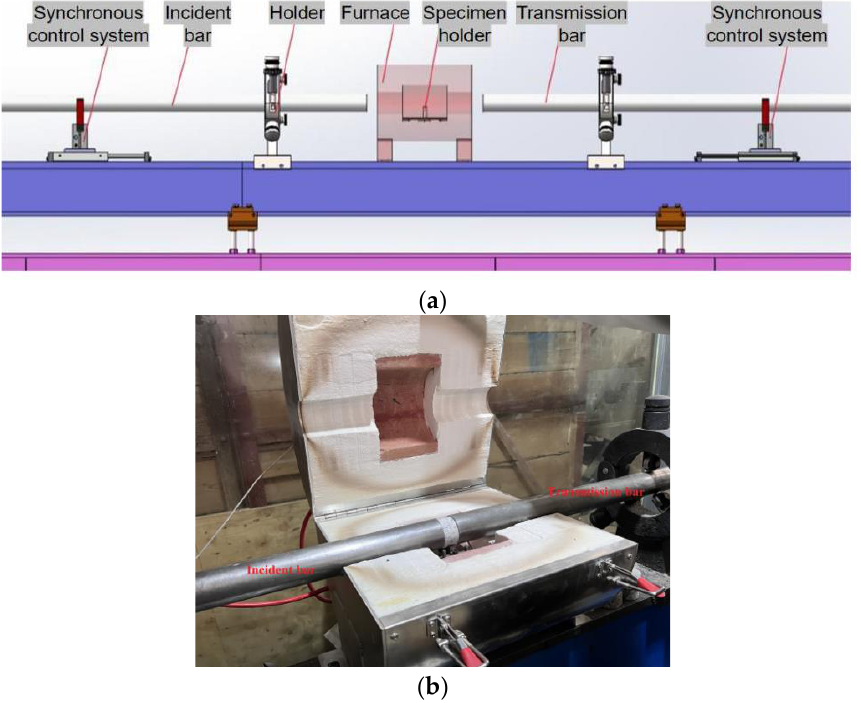
Figure 2. SHPB test system with an intelligent real-time high-temperature furnace. ( a ) Abridged general view, ( b ) real-time high-temperature furnace.